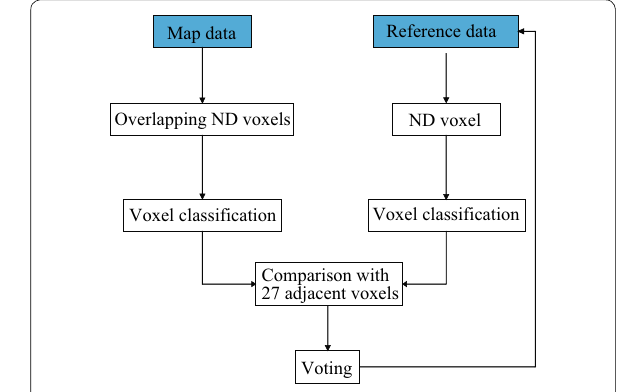
Fig. 1 Concept of NDT and ND voxels [17] Fig. 2 Spatial change detection